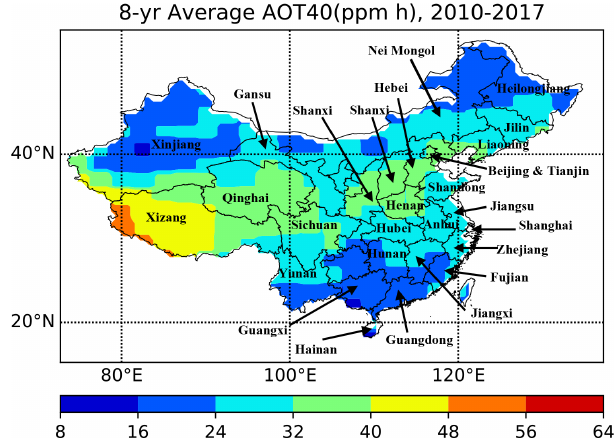
Figure 1. Spatial distribution of annual accumulated AOT40 (ppmh) in China for 8-year average (from 2010 to